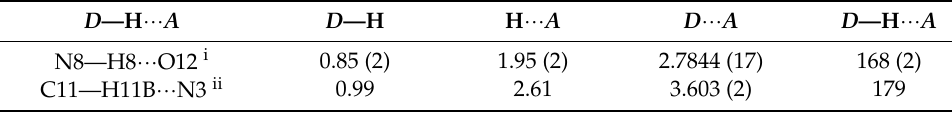
Table 1. Hydrogen-bond geometry (A) for 5c